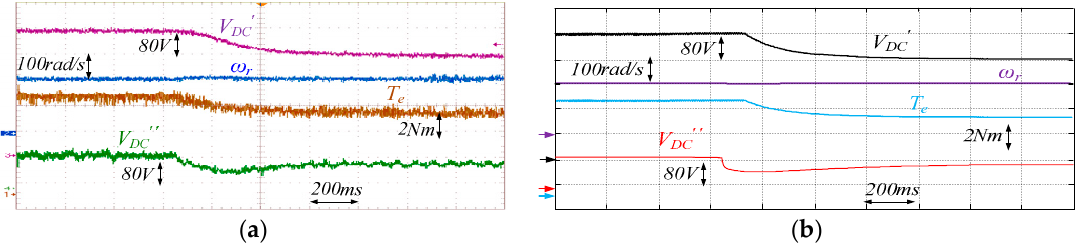
Figure 23. Voltage transient of V DC ' from 400 V to 320 V under a constant resistor value R L = 80 Ω . Output voltage V DC ' , TLI DC bus voltage V DC '' , rotor speed ω r , electromagnetic torque T e . ( a ) Experimental results. ( b ) Simulation results.